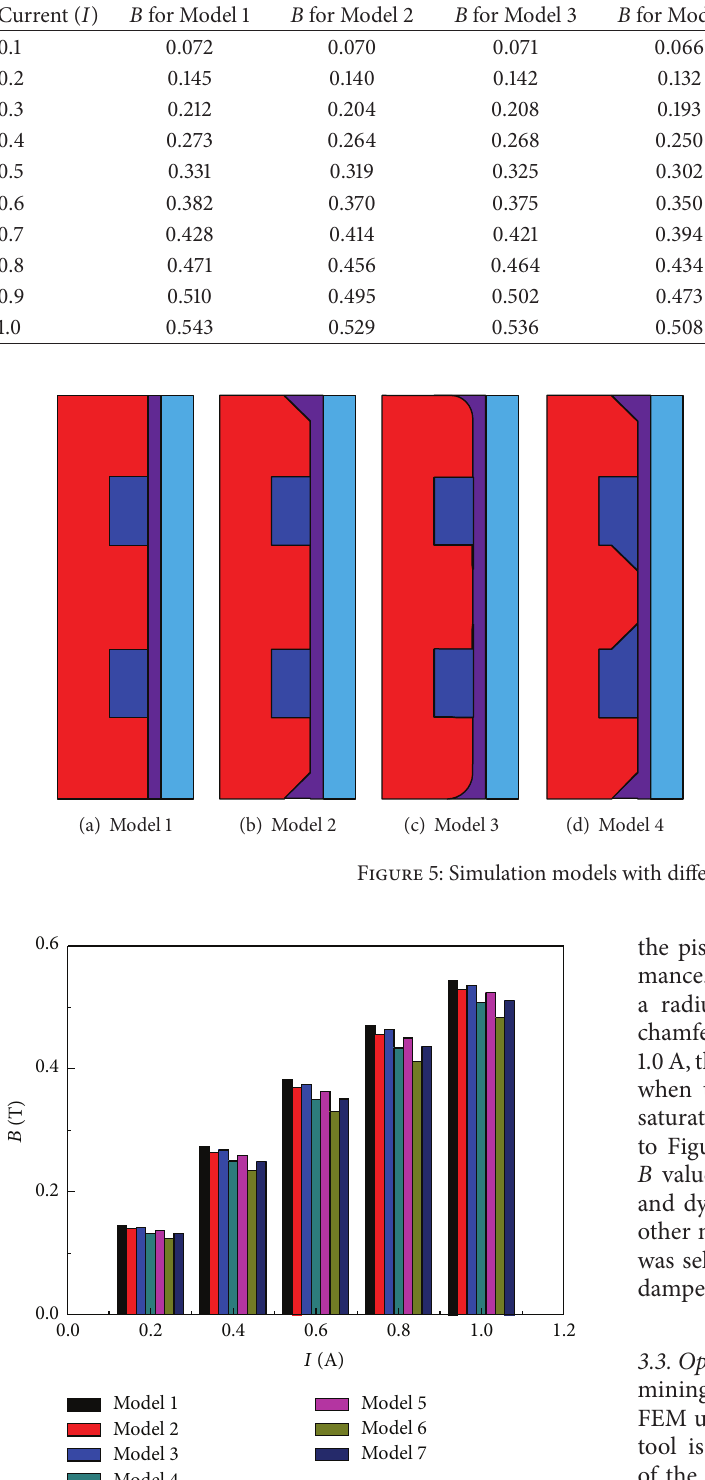
Figure 6: Magnetic flux density of different